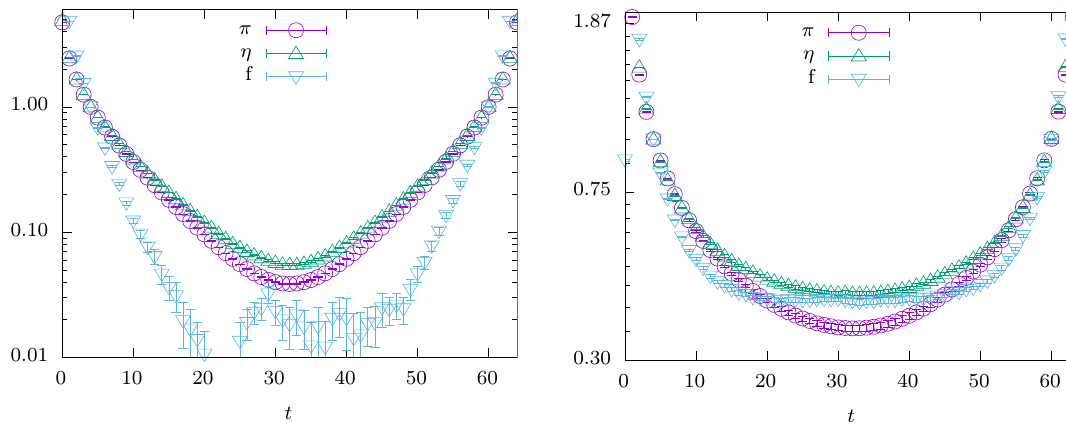
Figure 9. The (cid:17) -, (cid:25) - and f-meson correlation functions C ( t ) as function of the temporal extend t are shown for (cid:12) = 17 and (cid:20) = 0 : 26655 (left) and (cid:20) = 0 : 26903 (right).